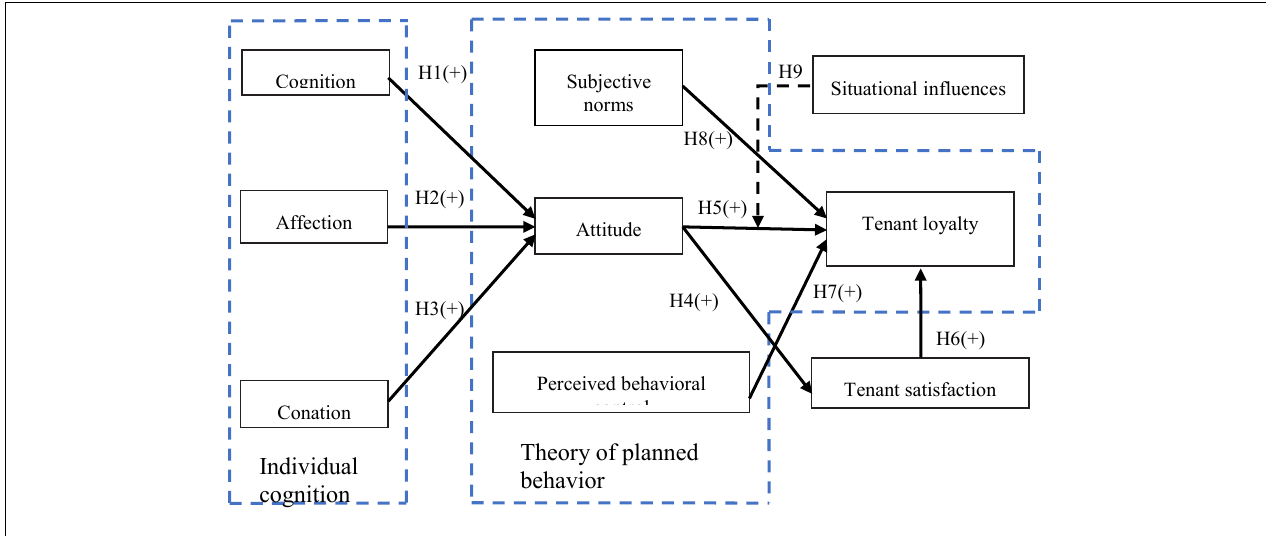
FIGURE 1 | The conceptual